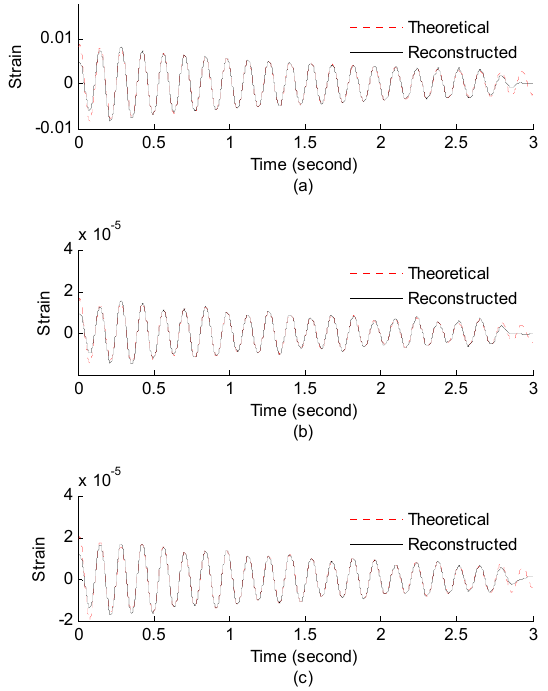
Figure 10. Reconstructed and theoretical strain responses for ( a ) the location I 1 ; ( b ) the location I 2 ; ( c ) the location I 3 .